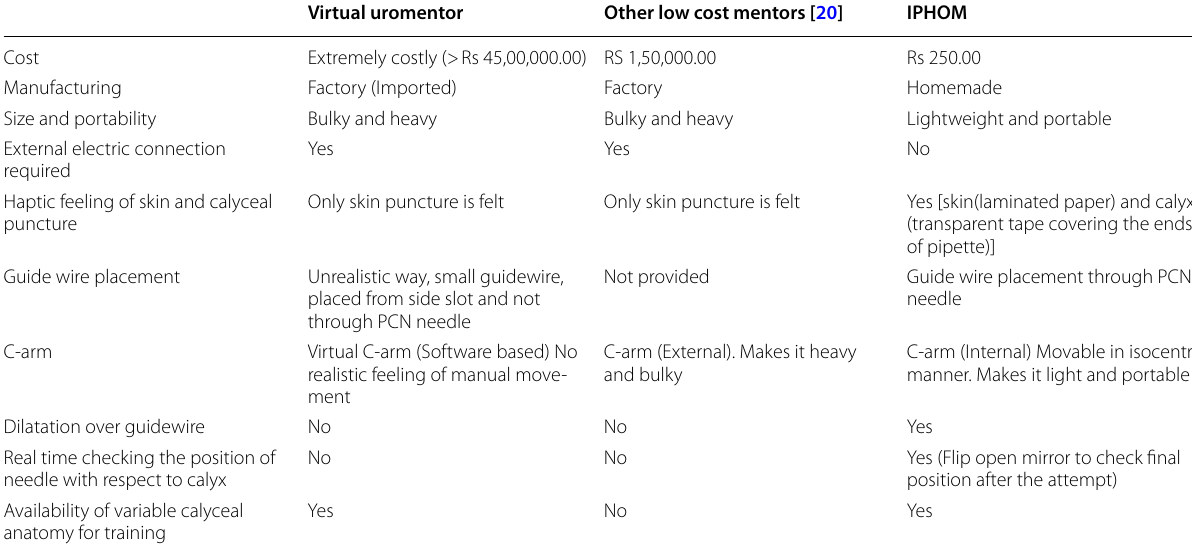
Table 2 Comparison of various PCNL training models with